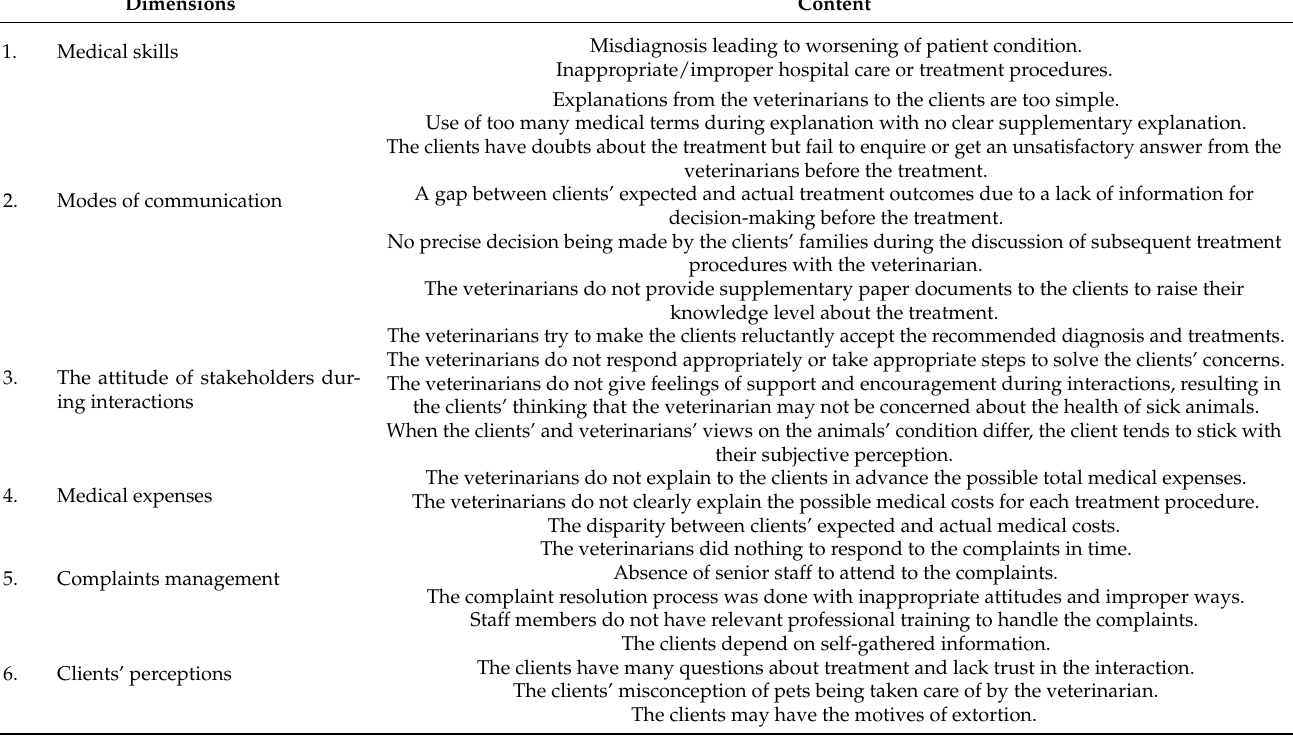
Table 1. Six dimensions of the questionnaire for measures of perceptions towards medical